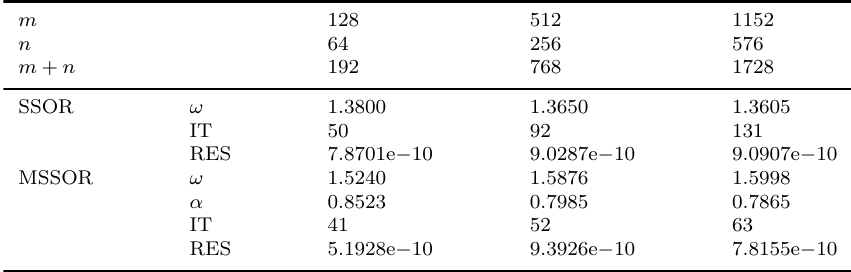
Table 5. The optimum parameters, IT and RES for this example when Q = − I ( γ = − 1). m 128 512 1152 n 64 256 576 m + n 192 768 1728 SSOR ω 1.3800